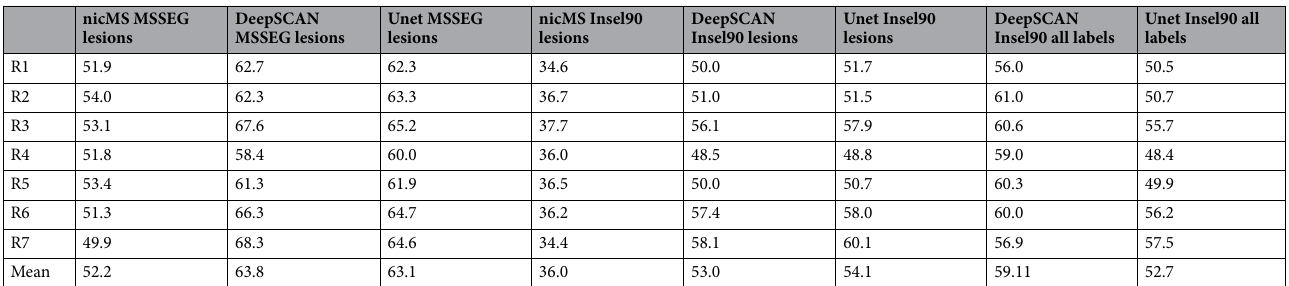
Table 4. Segmentation performance (Dice coefficient) versus the seven individual raters of the MSSEG